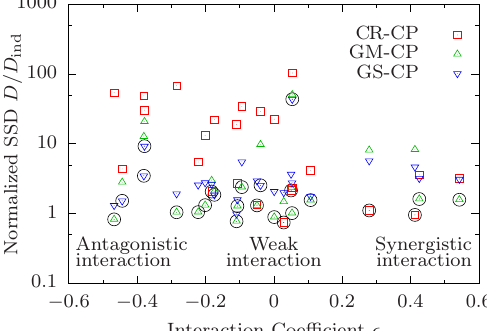
Figure A2. The sum of squared deviations D of survival curves satisfying a composition principle (CP) is divided by the SSD D ind of independently fitted curves and shown in dependence on the median interaction coefficient (cid:101) defined in Equation (18). Each symbol corresponds to a combination of a data quadruple and a CP. The CP yielding the best result for a given quadruple is marked by a black